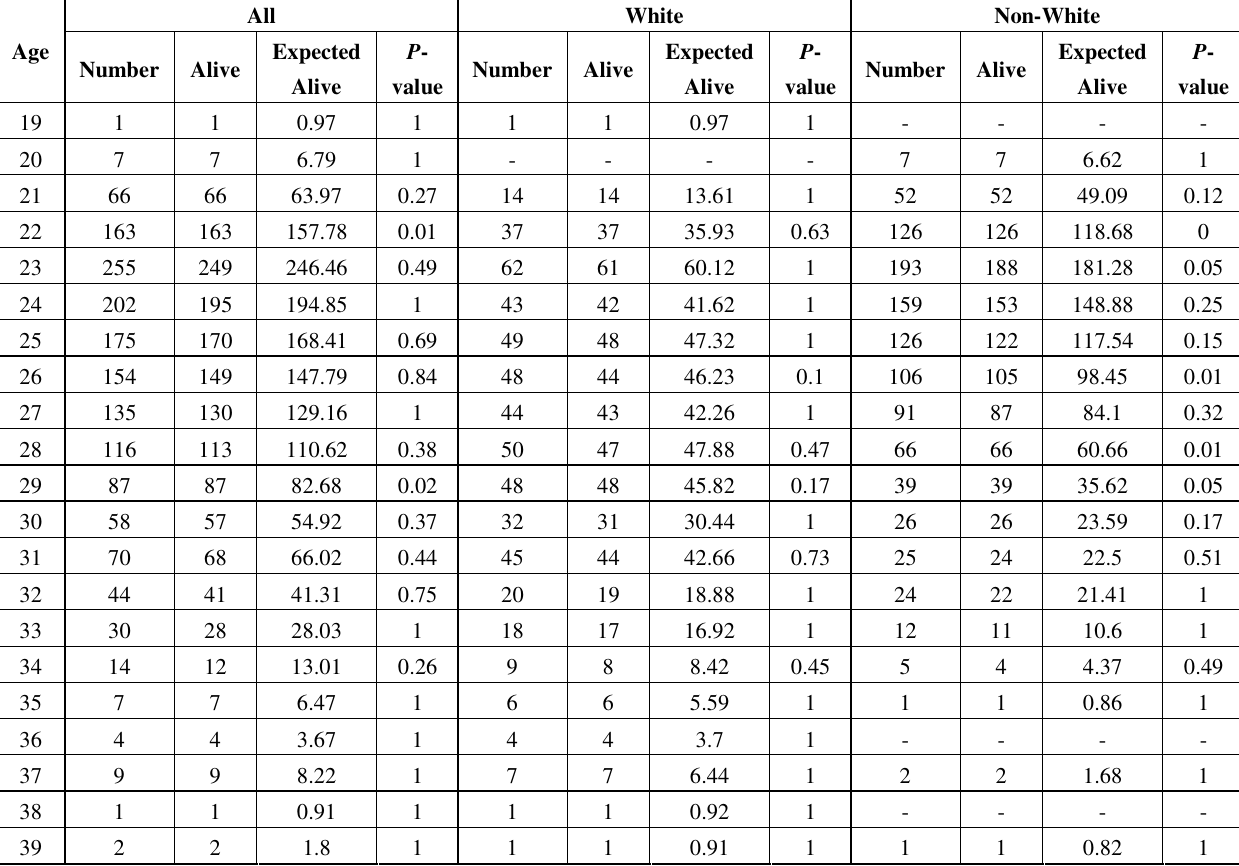
Table 3. Actual Survival and Expected Survival (1994